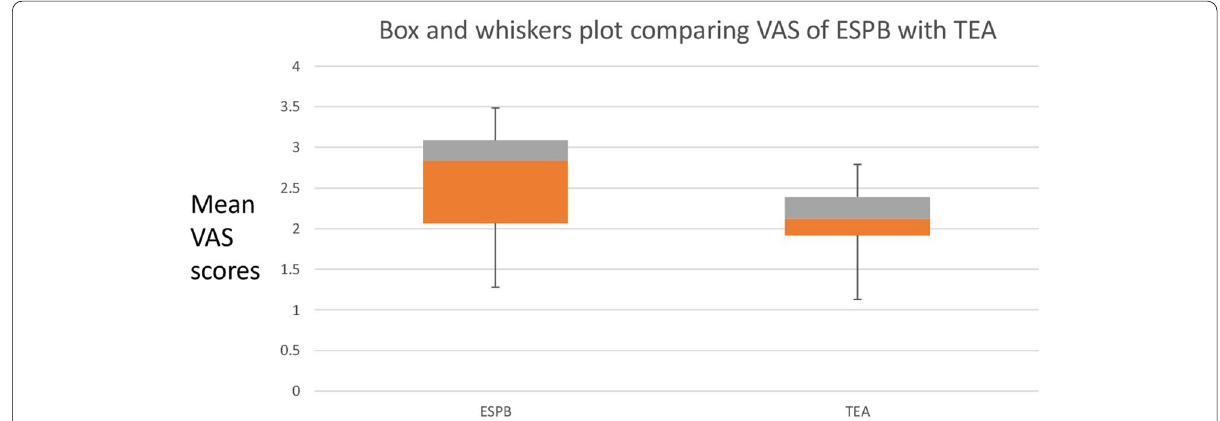
Fig. 2 Box and whiskers plot showing comparison of mean VAS scores between group E and group